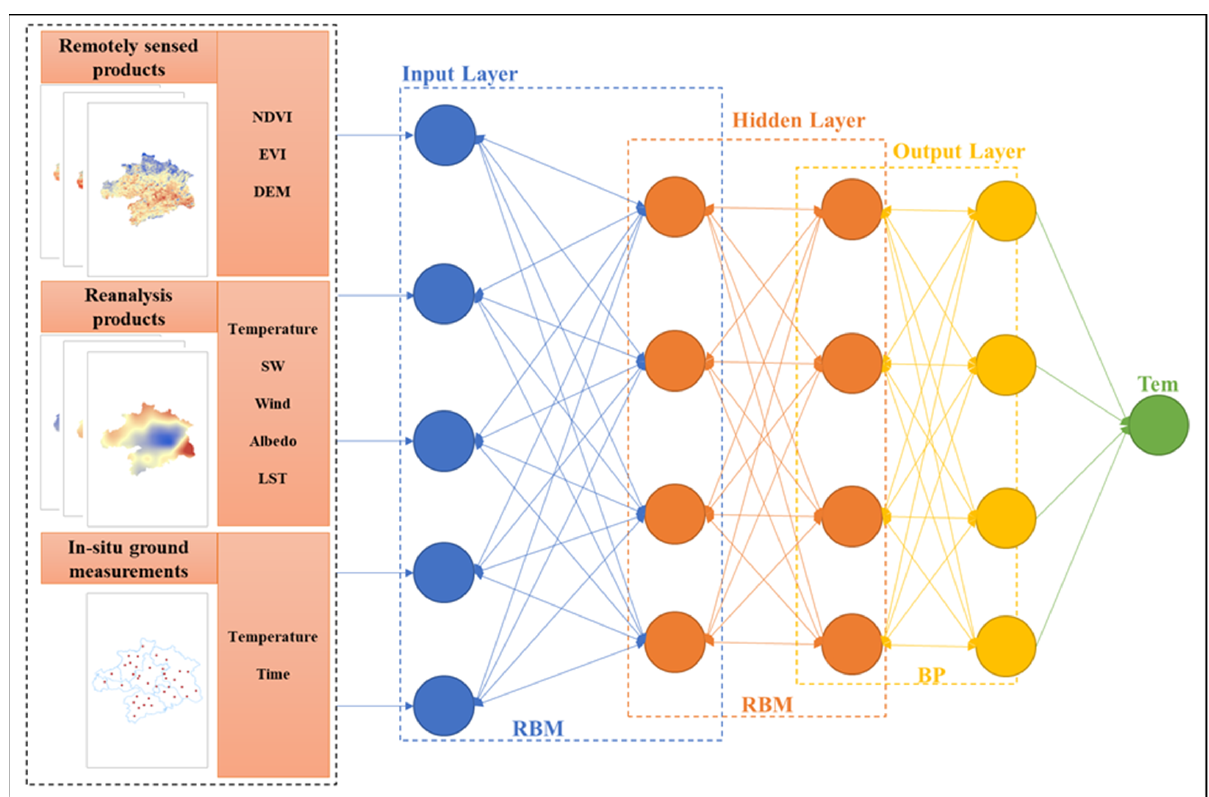
Figure 3. The structure of the proposed DBN model used for generating temperature data.